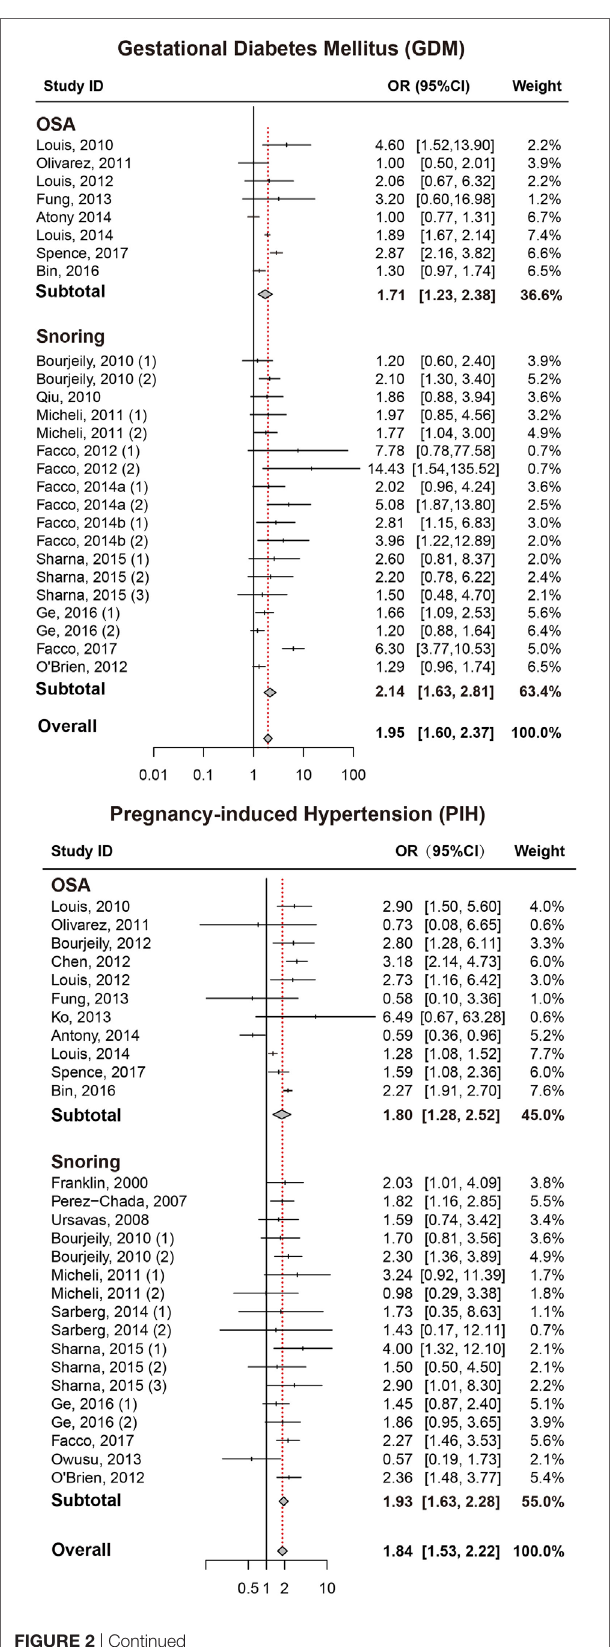
FigURe 2 | Forest plots of the association between GDM/PIH and SDB (snoring and OSA). Results are expressed as OR and 95% CI. GDM, gestational diabetes mellitus; PIH, pregnancy-induced hypertension; SDB, sleep-disordered breathing; OSA, obstructive sleep apnea; OR, odds ratio; CI, confidence interval. The numbers after authors were used to distinguish different groups within one